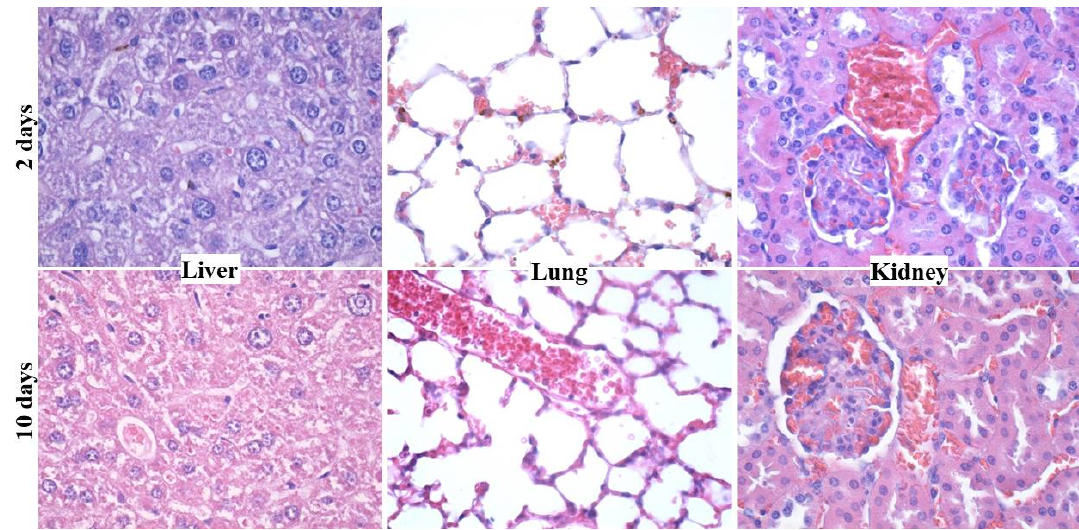
Figure 5. Optical micrographs of hepatic, pulmonary and renal tissues harvested after 2 and 10 days of treatment with Fe 3 O 4 @EG (400× magnification).